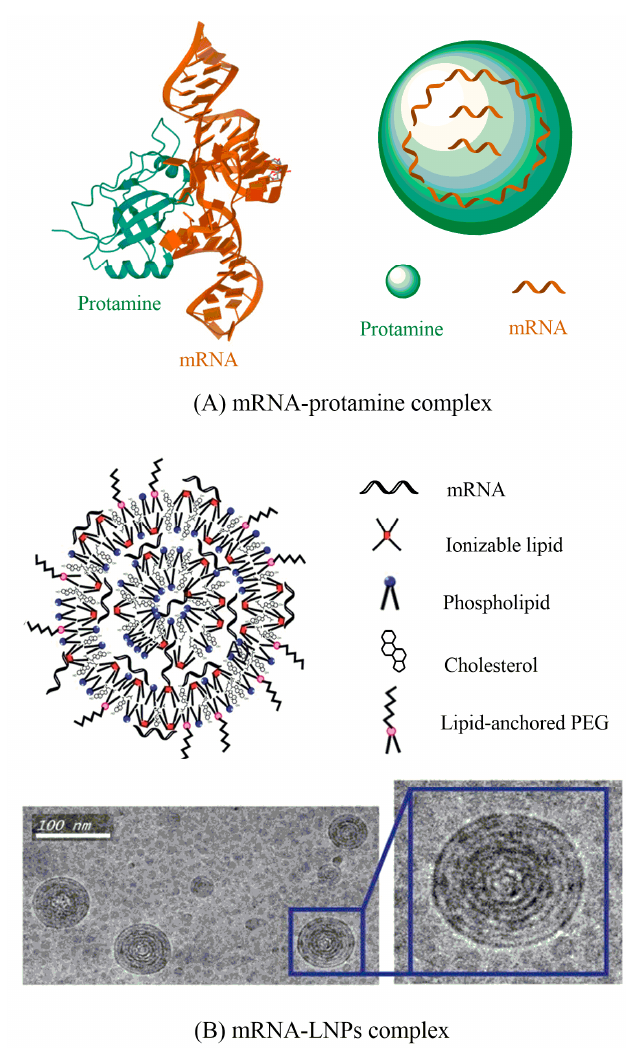
Figure 3. Formulations of mRNA with nanobiomaterial for in vivo drug delivery. ( A ) Protamine- complexed mRNA for drug delivery. ( B ) Synthetic components and electron microscopy images of various LNPs. LNPs have been reported to synthesize by mixing anionic mRNA with lipophilic compounds in ethanol using a microfluidic device. At lower pH, the lipid-mRNA complex can accelerate both endocytosis as well as endosomal escape. Phospholipid used during the formulation process gives structural integrity to the lipid bilayers and can contribute to the endosomal release of the mRNA to the cytoplasm. Cholesterol assists to stabilize lipid nanoparticles and stimulates membrane fusion. The lipid-coated PEG (poly-ethylene-glycol) prevents the aggregation of LNP and decreases nonspecific interactions (up). Cryogenic transmission electron microscopy image indicates that the lipid nanoparticles have a spherical shape consisting of a multilamellar structure (bottom) (Adapted with permission with little modification from